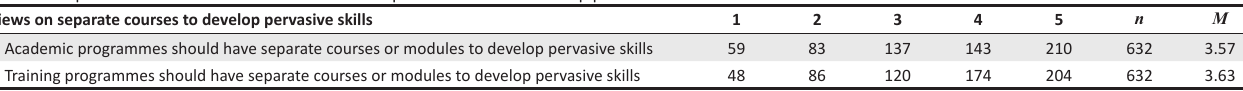
TABLE 5: Aspirant chartered accountants’ views on separate courses to develop pervasive skills. Views on separate courses to develop pervasive